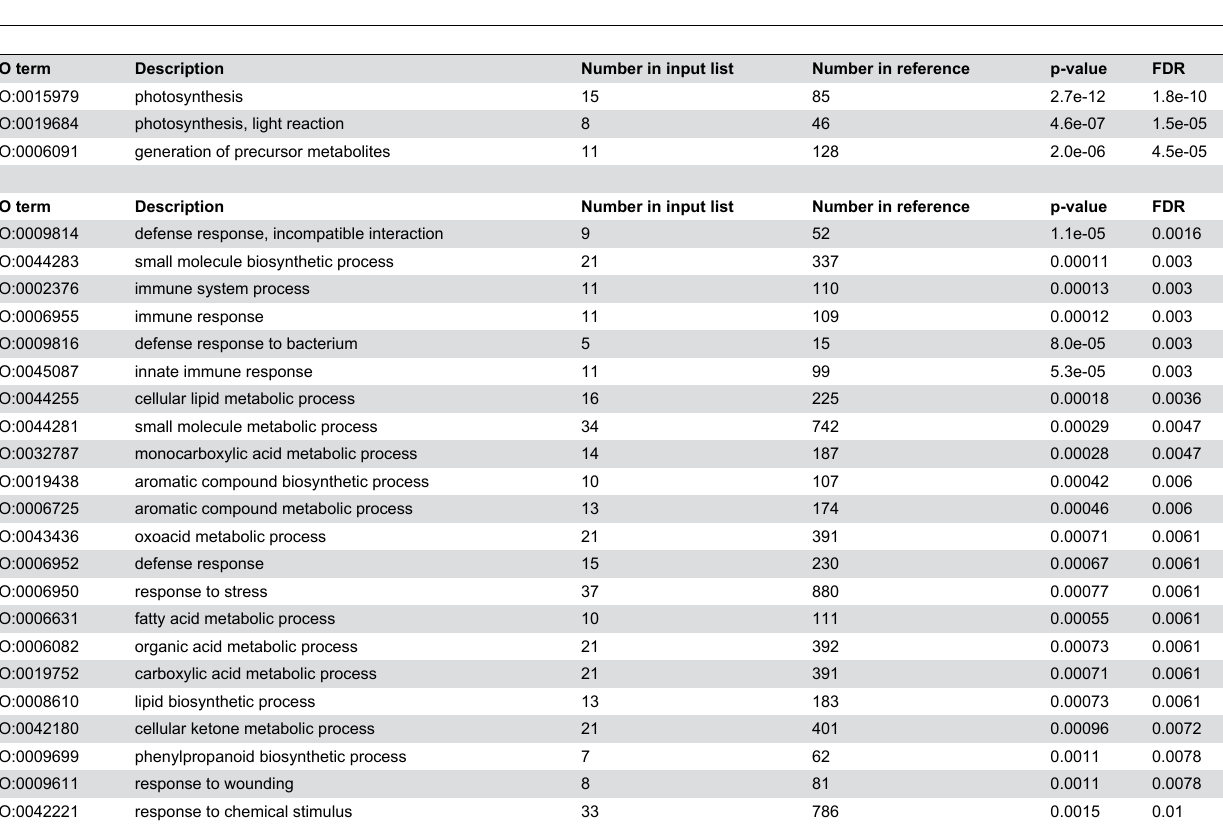
Table 1. Over-representation analysis of differentially expressed gene families during the orange interaction with Xanthomonas citri subsp. citri WT and Δ lov mutant for genes with M > 1 (A) and M < -1 (B), where M is log WT treatment/expression for Δ lov